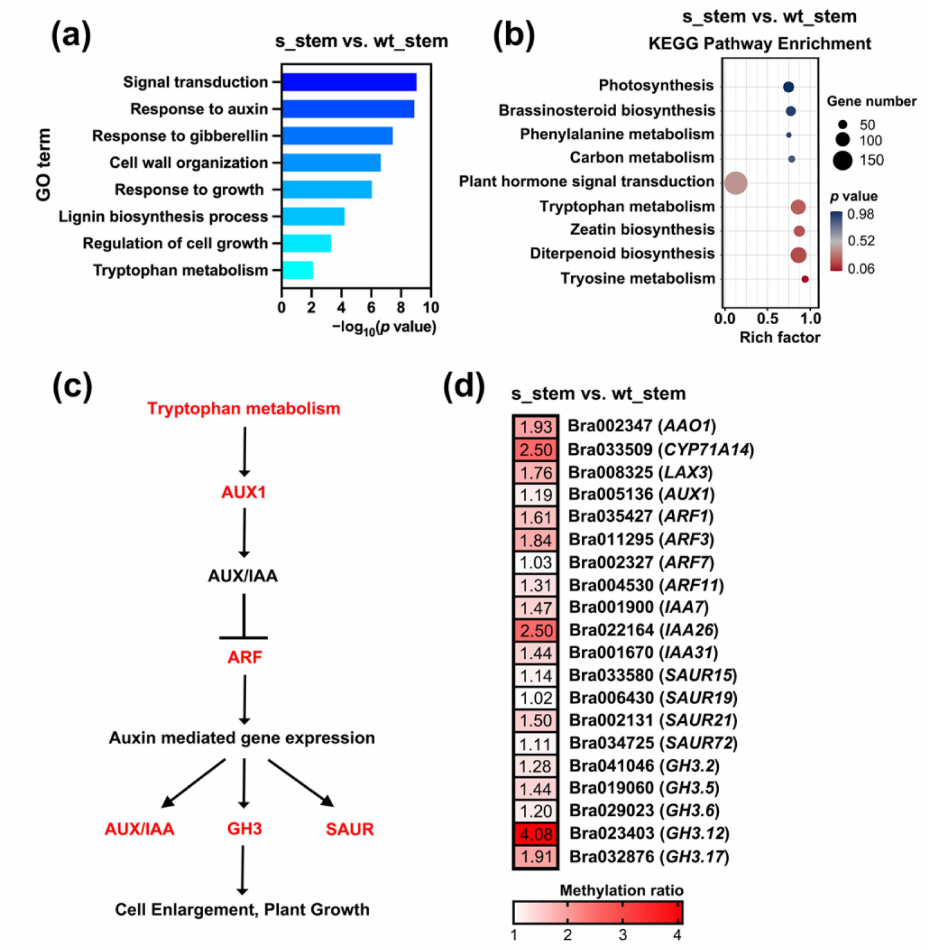
Figure 4. Functional analysis of DMGs in s_stem vs. wt_stem. ( a ) GO (gene ontology) functional enrichment of the DMGs in s_stem vs. wt_stem. ( b ) KEGG (Kyoto encyclopedia of genes and genomes) pathway analysis of the DMGs in s_stem vs. wt_stem. ( c ) The schematic diagram of auxin signal transduction pathway. ( d ) The methylation levels of auxin-related DMGs in s_stem vs. wt_stem. The hypermethylated DMGs identified in this study are marked in red. Arrows and “T” bars represent positive and negative regulation,